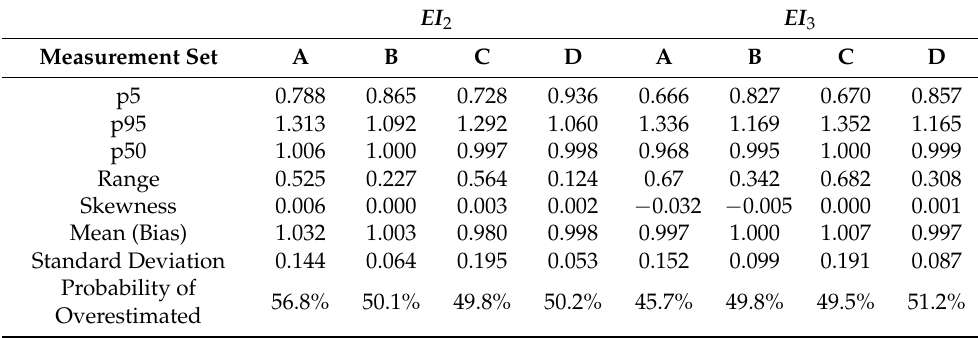
Figure 9. ECDF of estimated under different set considering aleatory uncertainty (the vertical dotted line represents the correct value, and the 5 and 95 percentiles are indicated with horizontal dotted lines). Table 5. Statistical data of the estimated EI 2 and EI 3 under different measurement